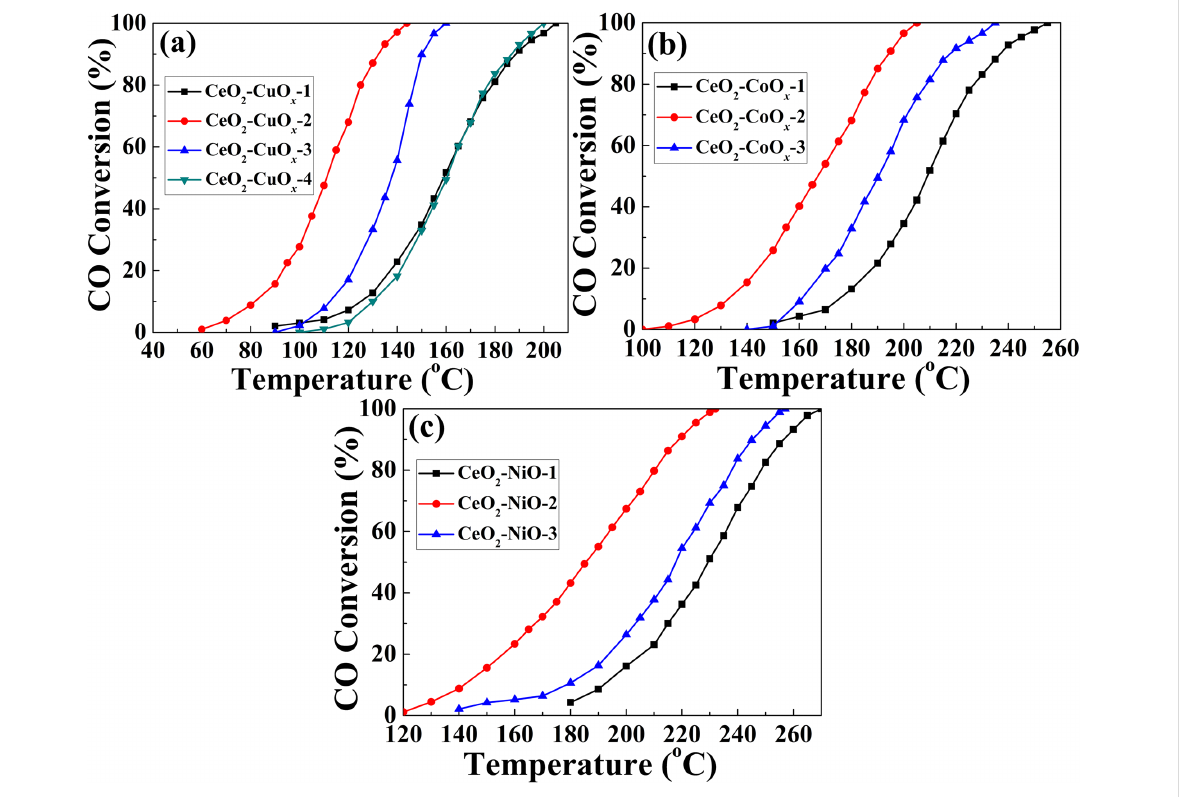
Figure 10: CO conversion as a function of temperature for CeO 2 –MO x composite yolk–shell nanospheres obtained with different initial concentra- tions of M(CH 3 COO) 2 · x H 2 O: (a) CeO 2 –CuO x ; (b) CeO 2 –CoO x and (c) CeO 2 –NiO.